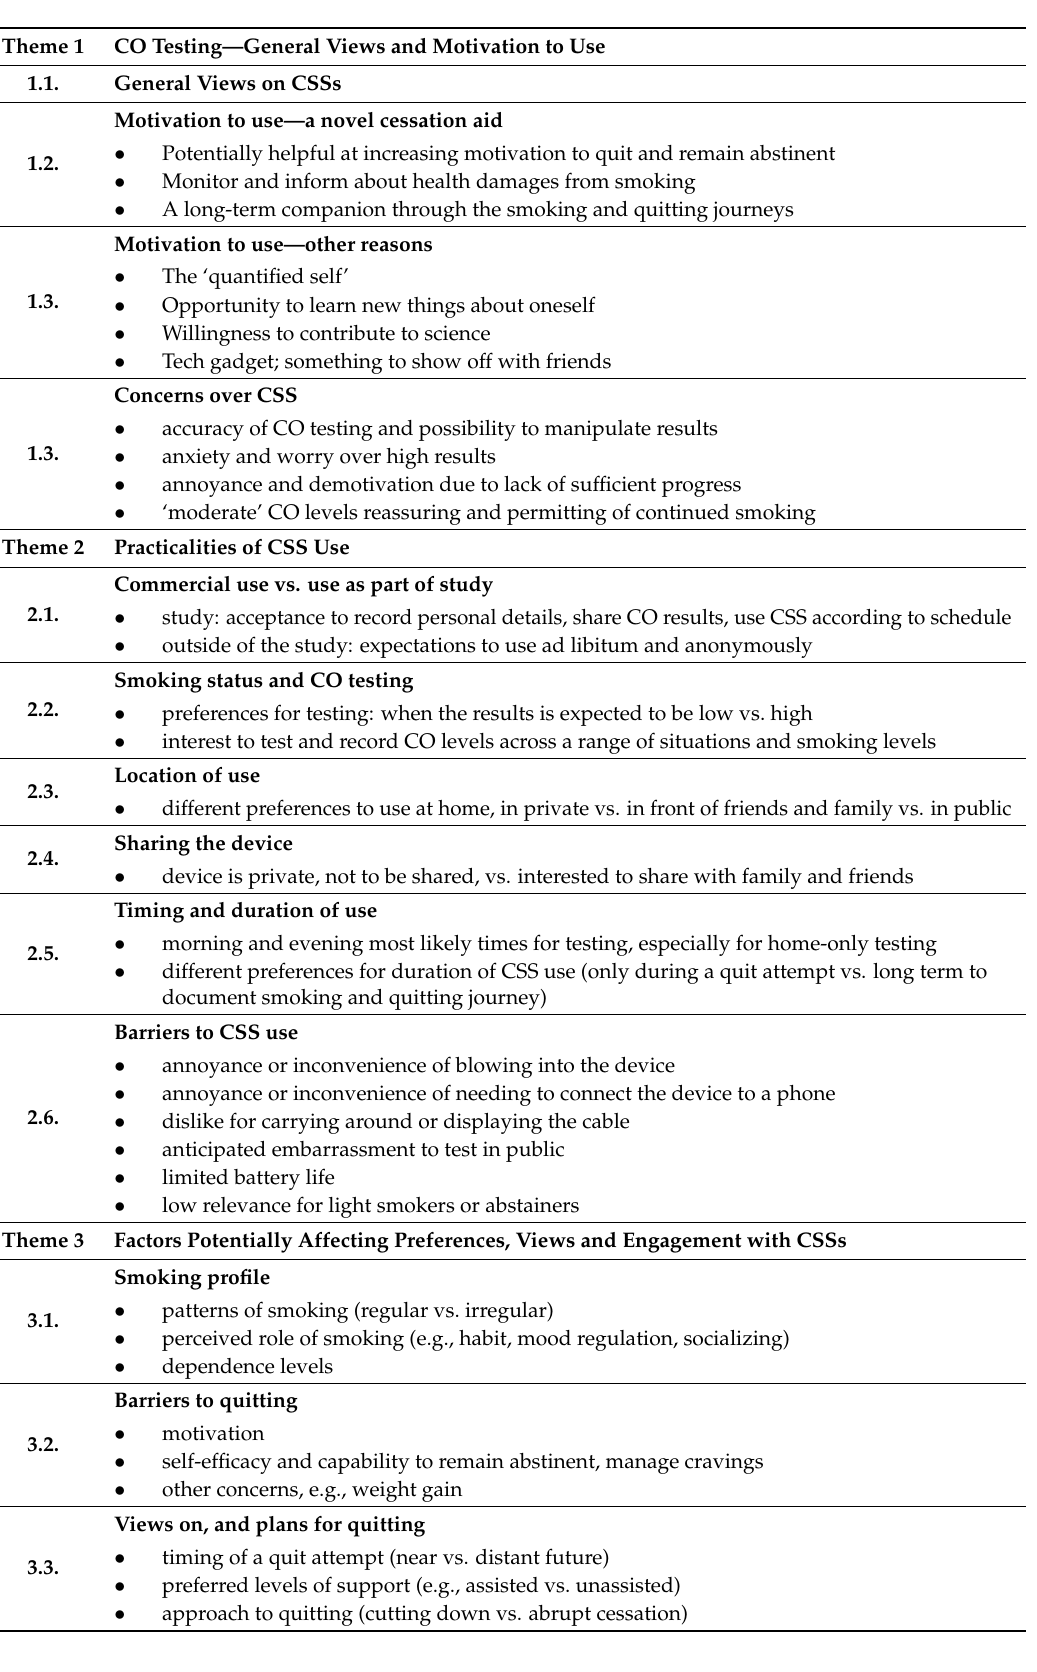
Table 2. Themes 1 to 3 and subthemes together with summary of core findings related to general views and expectations for CO Smartphone Systems (CSSs) and their